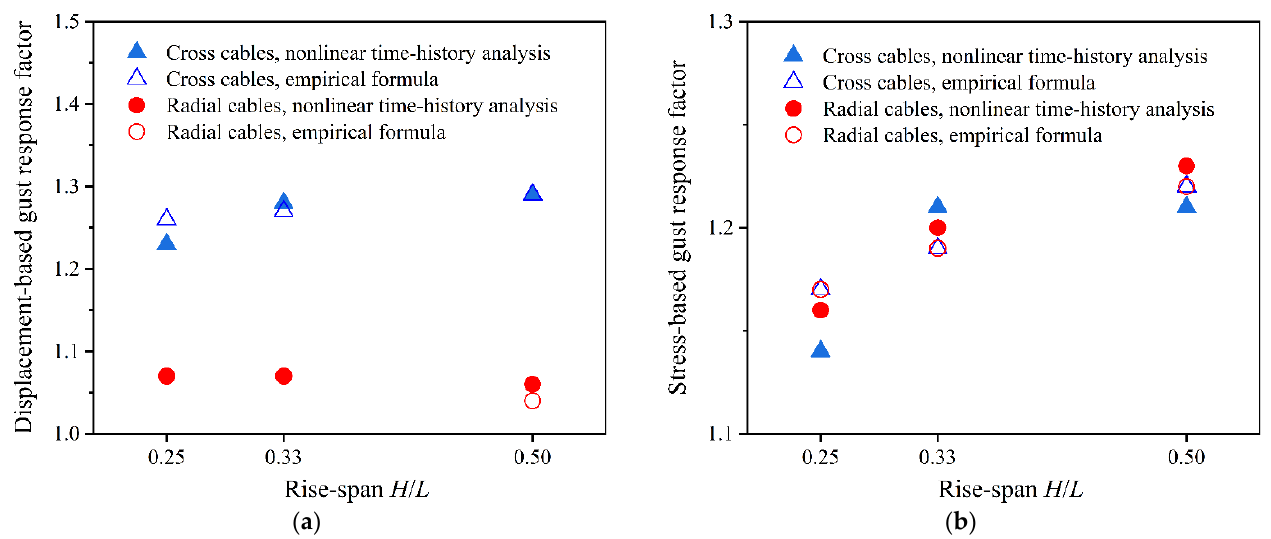
Figure 22. Comparisons of the gust response factors obtained by the proposed empirical formula and nonlinear time–history analysis: ( a ) Displacement; ( b ) Stress.